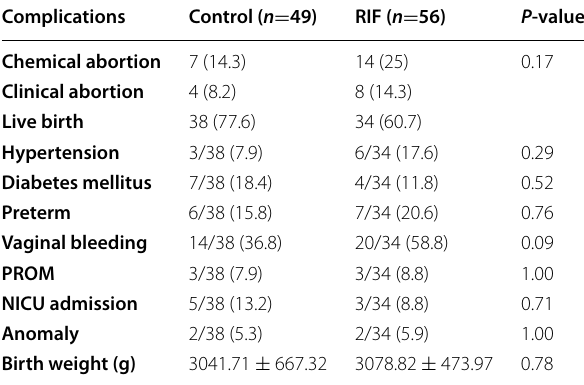
Table 6 Rates of obstetric and perinatal complications in control and RIF patients of the frozen-thawed ET cycles ( n